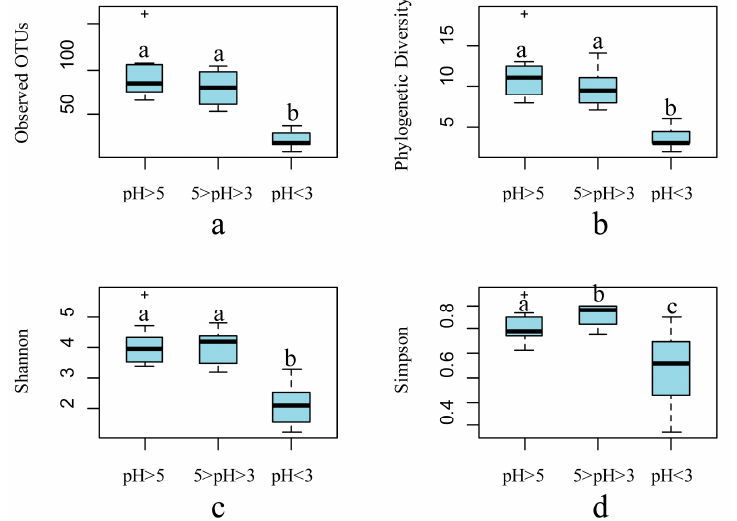
Figure 2. Microbial diversity characterized by ( a ) observed operational taxonomic units (OTUs), ( b ) phylogenetic diversity, ( c ) Shannon index, and ( d ) Simpson index at three acidification stages in simulated lab experiments on the oxidative dissolution of pyrite (data from [47]). In the figure, the horizontal bands within boxes represent the median and the bottom and top of boxes represent the first and third quartiles, respectively. The little plus symbols represent off-group points which are more than the interquartile range from the boxes. Different lowercase letters on the whiskers represent significant differences ( p -value < 0.05).